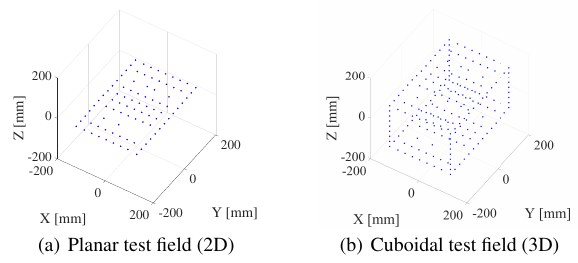
Figure 1. Two test fields for calibration. Additionally, the 3D test field was used for all measurement stage